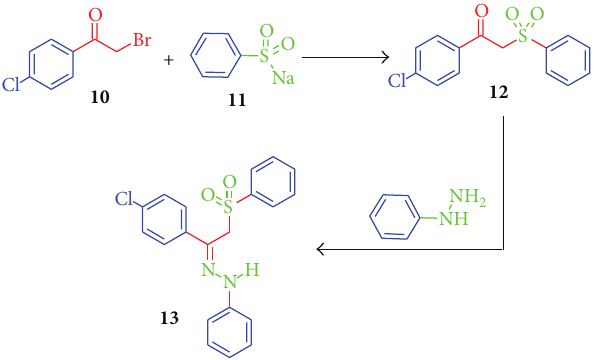
Scheme 1: Synthetic pathway of the title compound 13 .